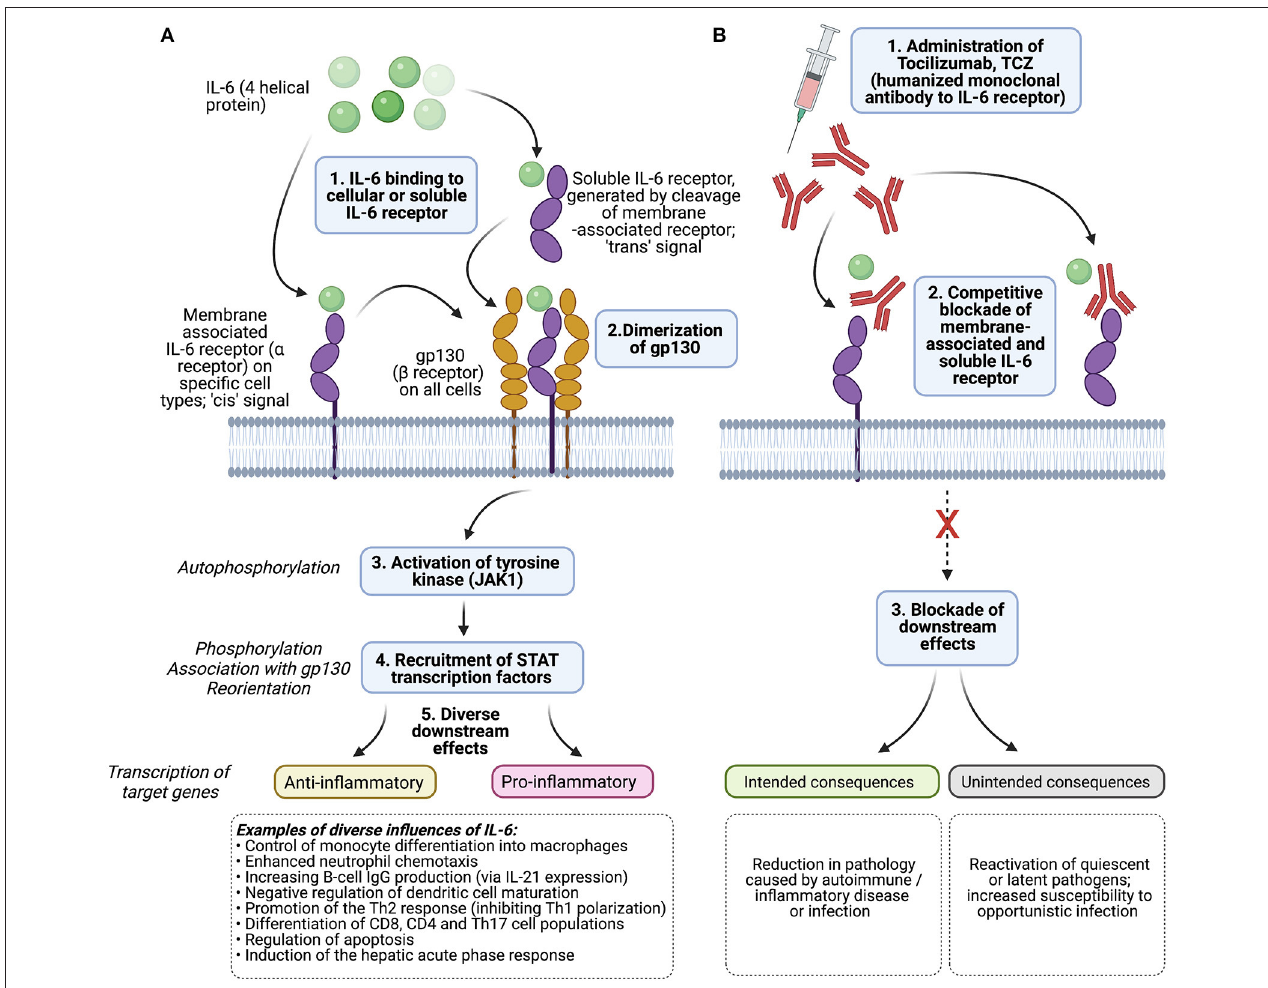
FIGURE 1 | Diagram to show (A) the mechanism of action of IL-6 and (B) the influence of tocilizumab, TCZ. The influence of IL-6 in viral infection is reviewed by Rose-John et al. ( 1) and Velazquez-Salinas et al. (2). gp130 is expressed on all cells in the body, IL-6 receptor is expressed by specific cells only (hepatocytes, monocytes/macrophages, CD4 + T cells, some epithelial cells). Cis- (“classical”) signalling is mediated through cell-associated IL-6 receptor, and associated with housekeeping, while trans-signalling describes the pathway associated with free soluble IL-6 receptor which may be more relevant in response to infection. Dimerization of gp130 causes a cascade starting with the autophosphorylation of Janus Kinase 1 (JAK-1). STAT, signal transducer and activator of transcription. Created with